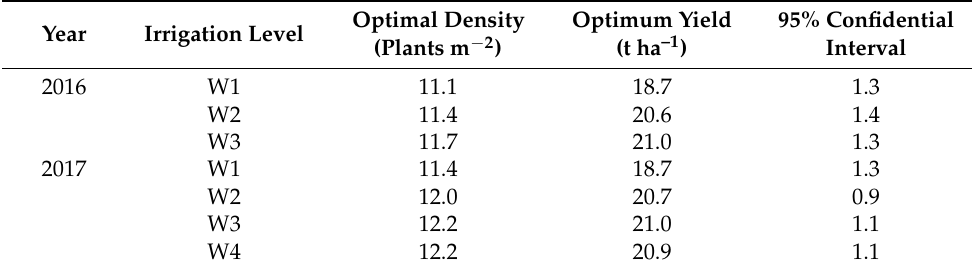
Table 6. The plant densities that were predicted to achieve the optimal yield for each irrigation levels and plant year.